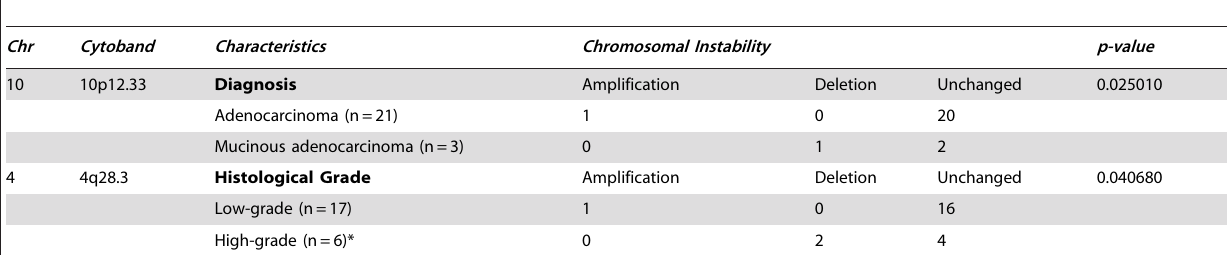
Table 4. Association of Chromosomal copy number changes with clinico-histopathological findings in MSI CRC cases (n= 24).